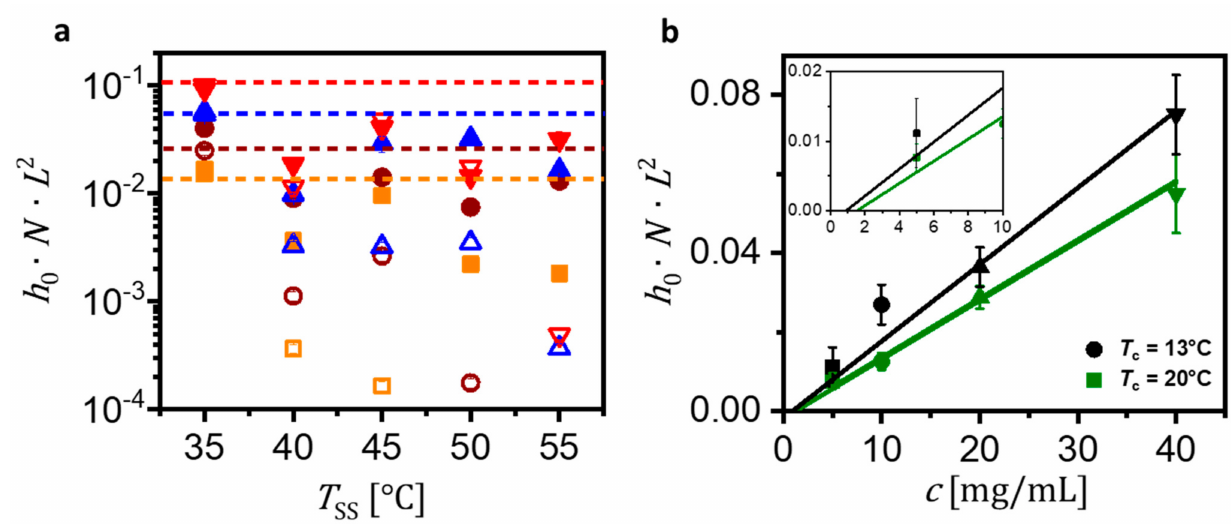
Figure 6. The effect of T SS on the volume of the obtained crystals, assumed to be mono-lamellar, i.e., h ≈ h 0 , η = 1; Amount ( V C ) of polymer in solution above the solubility limit, deduced from the total volume per area of all the crystals (assuming V C ≈ N · L 2 · h 0 ) obtained for various conditions. ( a ) Closed and open symbols represent data points of h 0 · N · L 2 as a function of T SS of crystals formed at T C = 13 ◦ C and T C = 20 ◦ C, respectively. Orange, brown, blue and red symbols represent results for c = 5 mg/mL, c = 10 mg/mL, c = 20 mg/mL and c = 40 mg/mL, respectively. The corresponding dotted lines indicate the values of h 0 · N · L 2 which are expected to be independent of T SS . Observed data points below these lines may indicate η > 1, especially for higher values of T SS ; ( b ) Plot of N · L 2 · h 0 (i.e., we assumed η = 1) for T SS = 35 ◦ C as function of c for T C = 13 ◦ C (black circles) and T C = 20 ◦ C (green squares), respectively. Linear fits to these data points extrapolated to N · L 2 · h 0 = 0 (magnified in the inset) yielded values for the solubility limit c ∗ . We obtained c ∗ ≈ (1 ± 0.3) mg/mL and c ∗ ≈ (1.5 ± 0.3) mg/mL for T C = 13 ◦ C and T C = 20 ◦ C,